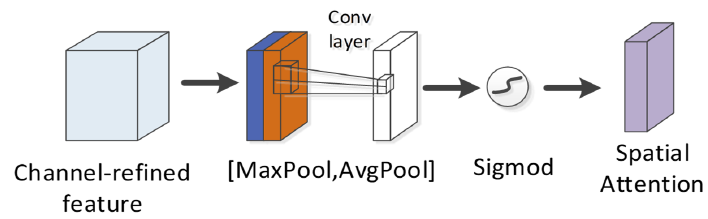
Figure 12. Spatial attention module in